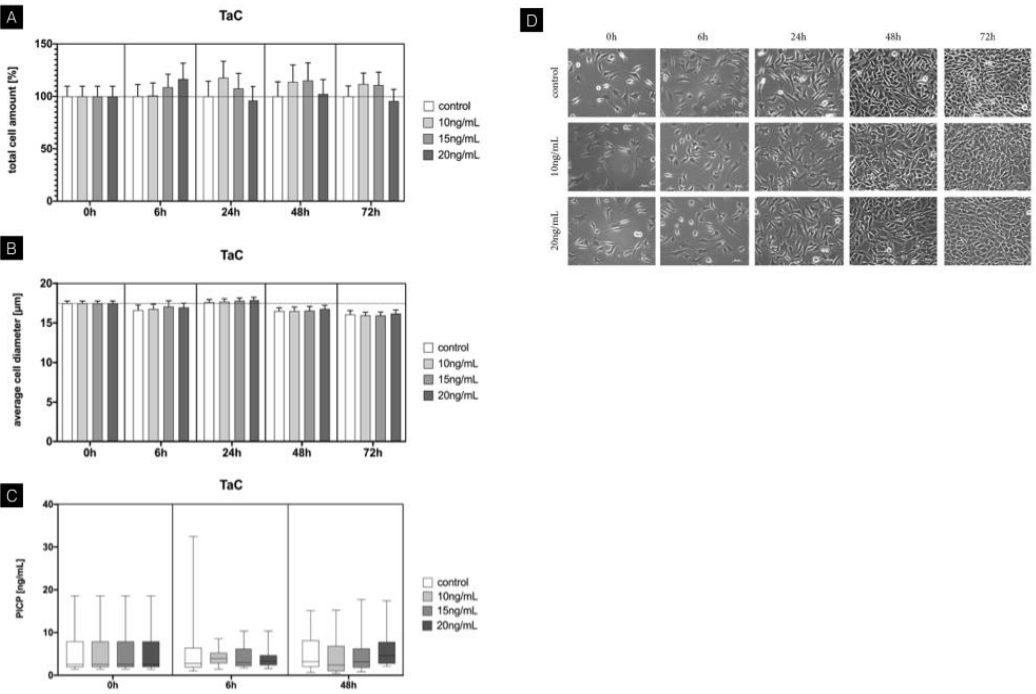
Figure 3. Time-dependent influence of tacrolimus on mouse fibroblasts . ( A ) Total cell amount (baseline-corrected). Upregulation after 6 h at intermediate and high concentrations of 15 ng/mL and 20 ng/mL. Persistent increase in cell amount after 24 h using low and intermediate concentrations. No significant changes using high concentrations of 20 ng/mL after 24 h. ( B ) Average cell diameter was slightly reduced using TaC after 48 h for all concentrations. ( C ) Procollagen concentration with no significant changes using different concentrations of TaC. ( D ) Cell morphology evaluation using light microscopy between 6 h and 72 h. Overall increased cell confluence with longer inoculation periods. Columns and error bars represent the mean ± SEM (n = 12); significant ( p < 0.05).